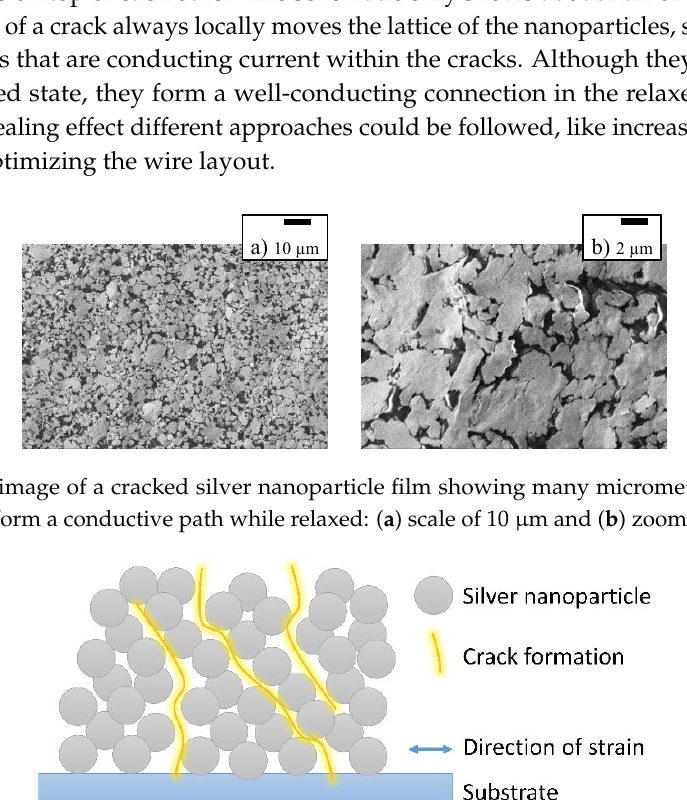
Figure 6. The sheet resistance of the inkjet-printed silver wires after two days of relaxation during the cyclic stretching test.